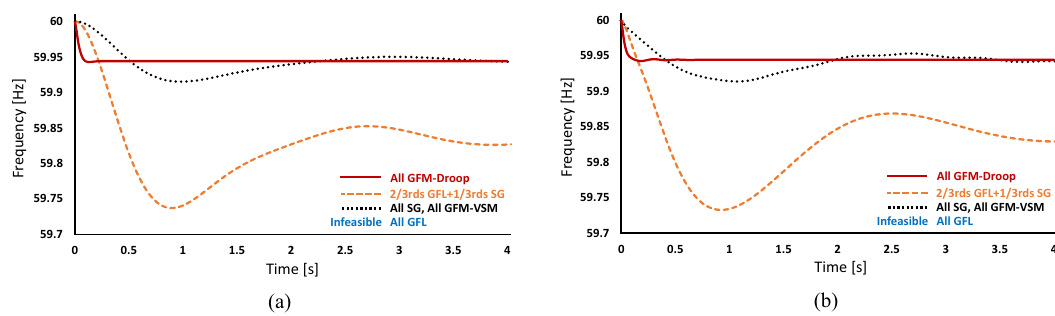
Fig. 4 Validation of the analytical model using a high-order model implemented in an industry-grade power system planning software for electromagnetic transient (EMT) dynamic modeling parameters are varied. a Results from generic second-order analytical models developed in this paper, b results from full-order models in Power Systems Computer Aided Design (PSCAD), available open-source 62 . The results here show the dynamic frequency response for a 3-generator, 9-bus network with different generation technologies. There are three main points of note. First, the frequency response for the three scenarios of “ All Synchronous Generator (SG)", “ All virtual machine grid-forming (GFM-VSM)", and “ 2/3rd grid-following (GFL) + 1/ 3rd SG" are very similar. Second, operating a network with 100% GFL is infeasible because mathematically, the denominator of the Jacobian elements cannot be zero (100% GFL implies M = 0) and practically, there will be no source to construct the synchronization frequency for the GFLs to follow. Third, and perhaps the most signi fi cant point, when operating with 100% multi-loop droop grid-forming (GFM), the effective inertia value is reduced to near zero and the GFM frequency response can be seen effectively as fi rst-order and therefore be less likely to experience severe frequency excursions. This corroborates with the observations reported in ref. 63 . The inertia and damping coef fi cients for these cases and the quanti fi cation of their dynamic response are presented in Supplementary Table II.